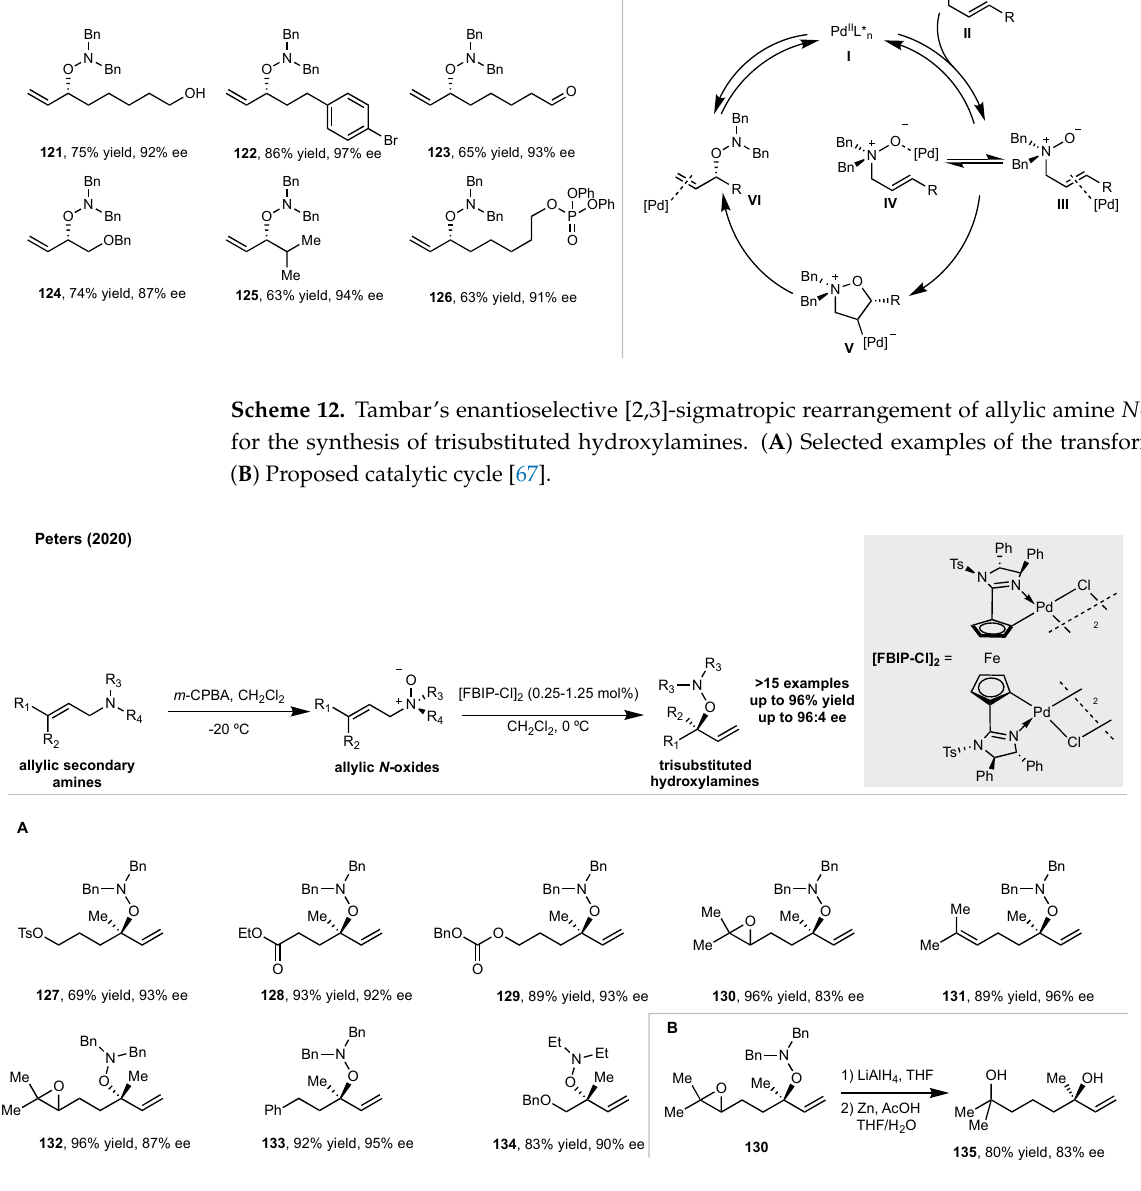
Scheme 13. Peters(cid:31) enantioselective [2,3]-sigmatropic rearrangement of allylic amine N -oxides for the synthesis of O - tert -alkyl trisubstituted hydroxylamines. ( A ) Selected examples of the transfor- mation. ( B ) Elaboration of the products to complex tertiary alcohols [67,70].